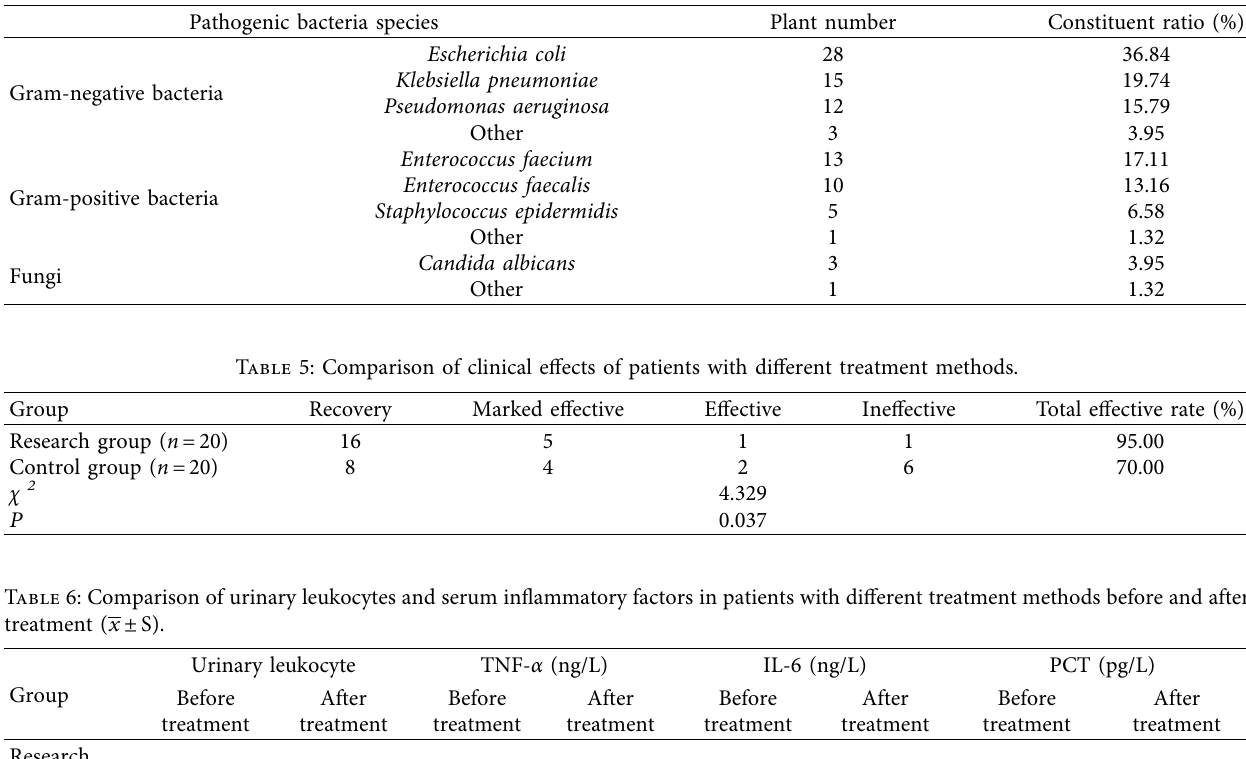
Table 4: Urine-derived pathogenic bacteria infection and distribution in BPH patients after operation.